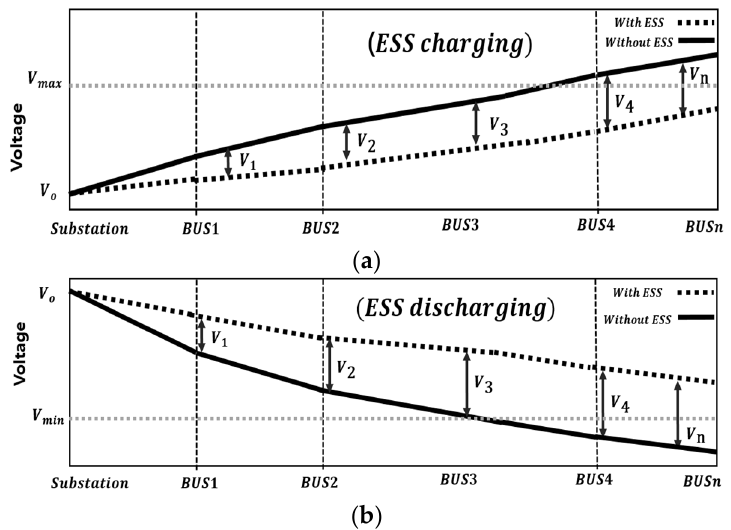
Figure 2. Voltage regulation by the bidirectional power flow in MG.